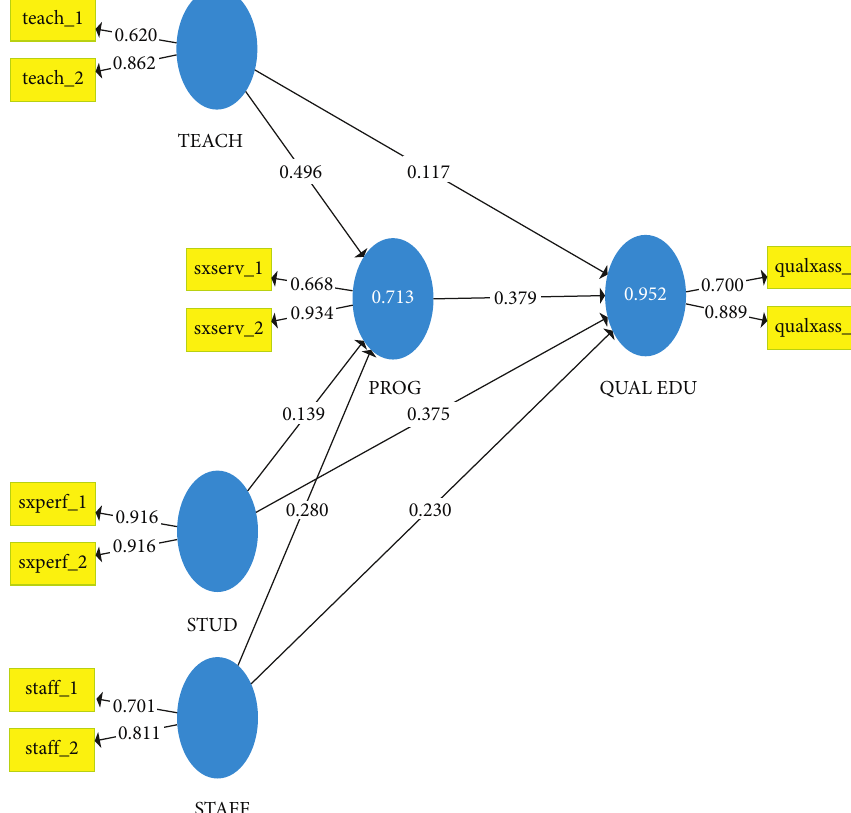
Figure 3: Path analysis results.